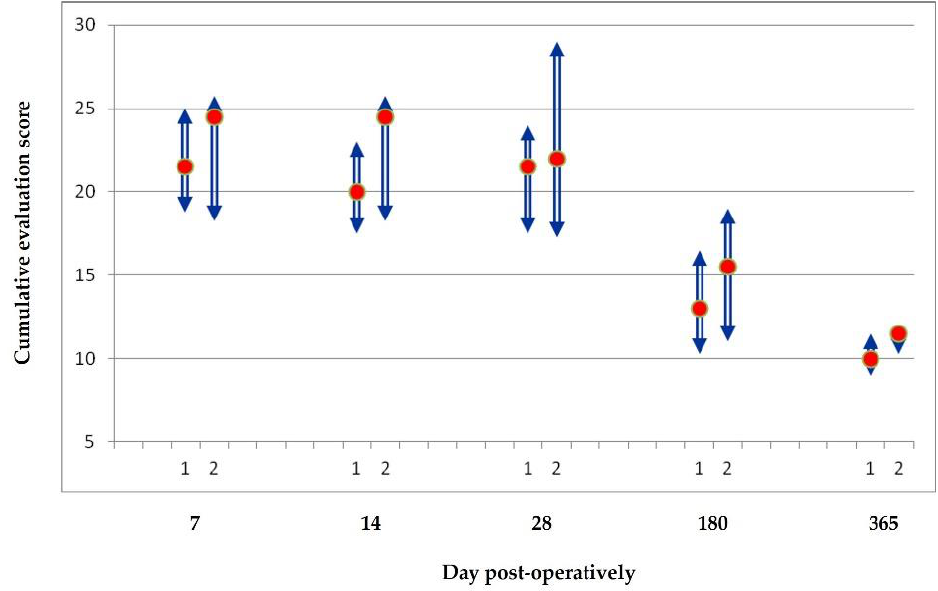
Figure 4. Cumulative evaluation score (median score (red dot) and interquartile range (column)) for each suturing material (1: P25, 2: P6211) during the study.